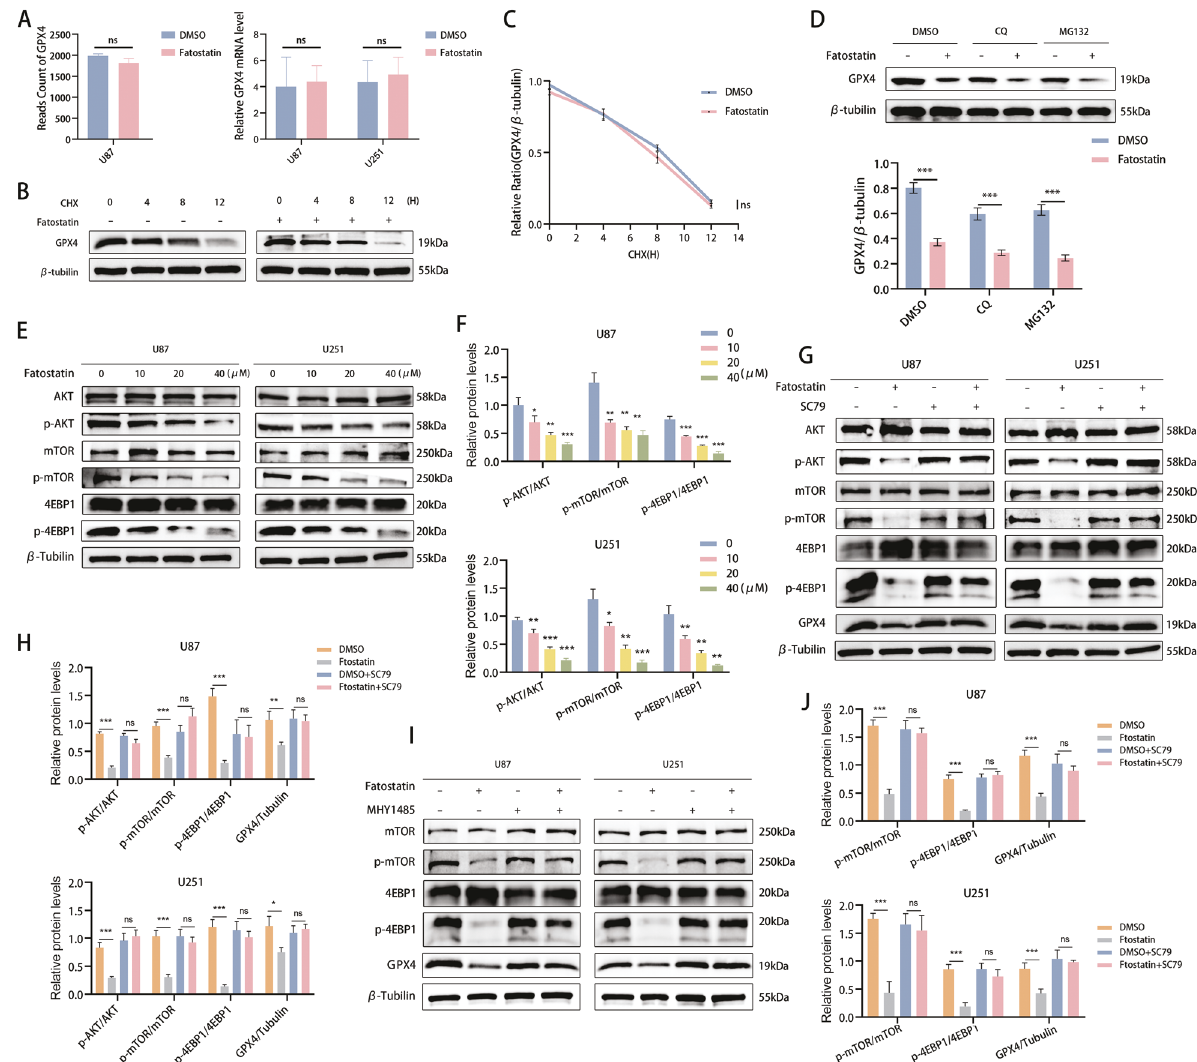
Fig. 5 Fatostatin decreases GPX4 protein synthesis through the AKT/mTORC1/4EBP1 axis. A RNA-seq and RT ‒ PCR results showed that the mRNA level of GPX4 was not signi fi cantly different between the DMSO and fatostatin groups. B , C Western blotting was used to analyze the GPX4 protein levels after the cells were treated with or without fatostatin (20 μ M) for 24 h and CHX (50 μ M) for different durations (0, 4, 8, 12 h). D Western blot analysis of the GPX4 protein levels in the U87 cells treated with DMSO, CQ (lysosomal inhibitor, 10 μ M), or MG132 (proteasomal inhibitor, 10 μ M) with or without fatostatin (20 μ M) treatment for 24 h. Lower panels show the statistical analysis of the data, n = 3. E , F The protein expression levels of AKT, p-AKT, mTOR, p-mTOR, 4EBP1, and p-4EBP1 in U87 and U251 cells after fatostatin treatment for 24 h. G , H SC79 (AKT activator, 10 μ M) reversed the relative protein expression levels of p-AKT, p-mTOR, p-4EBP1, and GPX4 in the U87 and U251 cells treated with fatostatin (20 μ M) for 24 h. I , J MHY1485 (mTOR activator, 10 μ M) reversed the changes in relative protein expression levels of p-mTOR, p-4EBP1, and GPX4 in the U87 and U251 cells treated with fatostatin (20 μ M) for 24 h. * P < 0.05, ** P < 0.01, *** P < 0.001; ns no signi fi